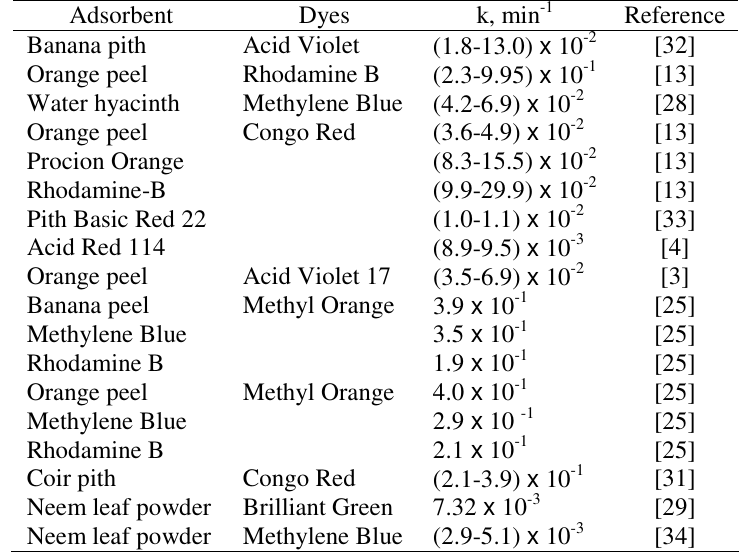
Table 1. Pseudo first order rate constant data for adsorption of dyes on various